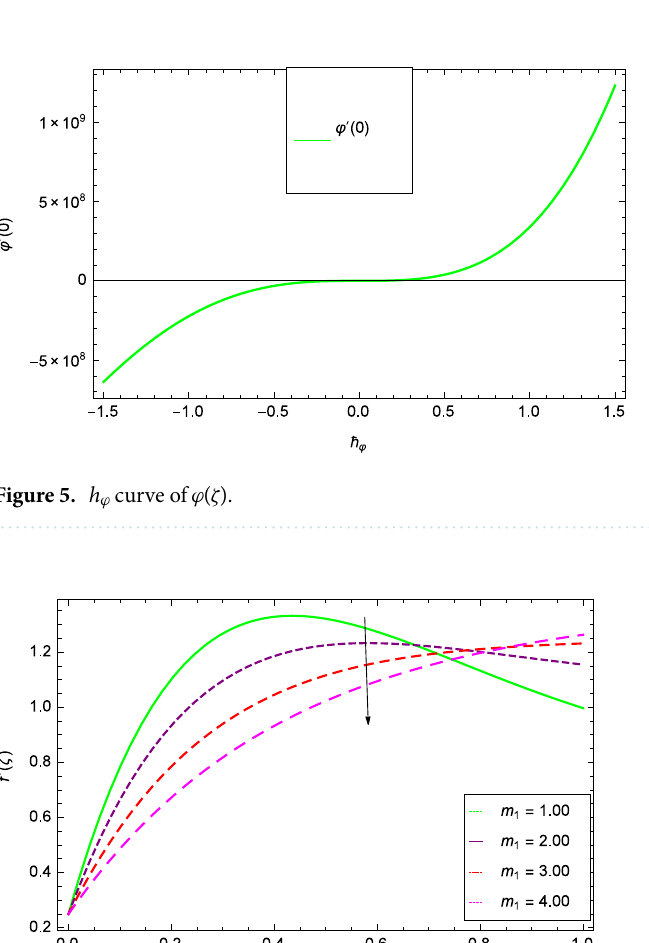
Figure 4. h θ curve of θ ( ζ ).